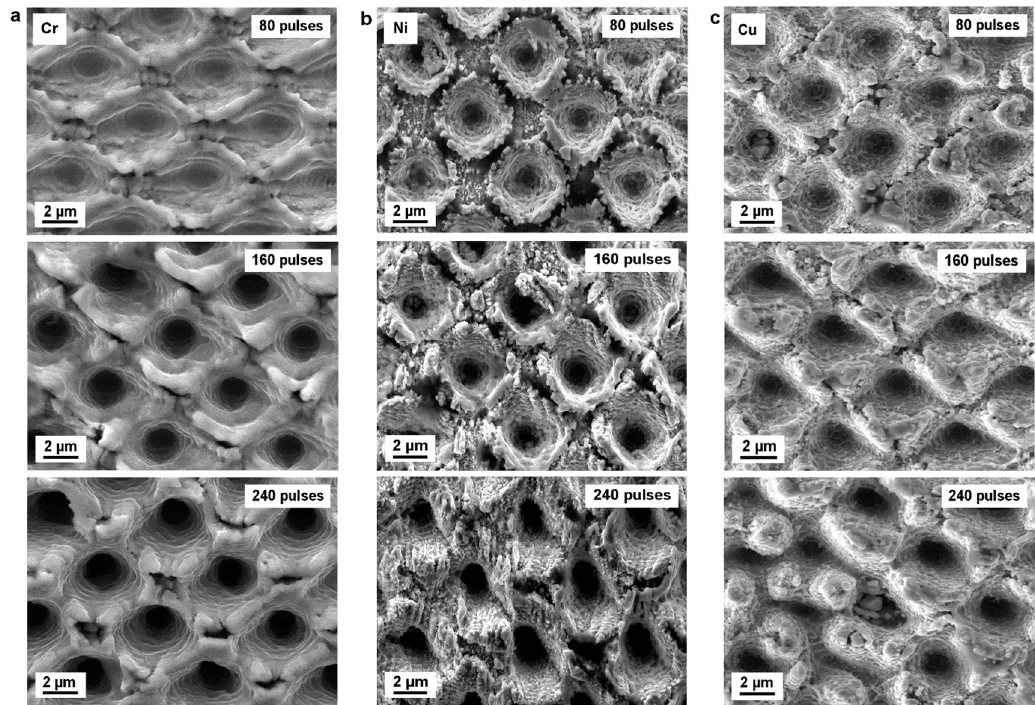
Figure 4. SEM images of ( a ) Cr, ( b ) Ni, ( c ) Cu substrates structured by direct laser interference patterning. The hole-like patterns were fabricated with a laser fluence of 2.9 J / cm 2 and di ff erent numbers of laser pulses: 80, 160, and